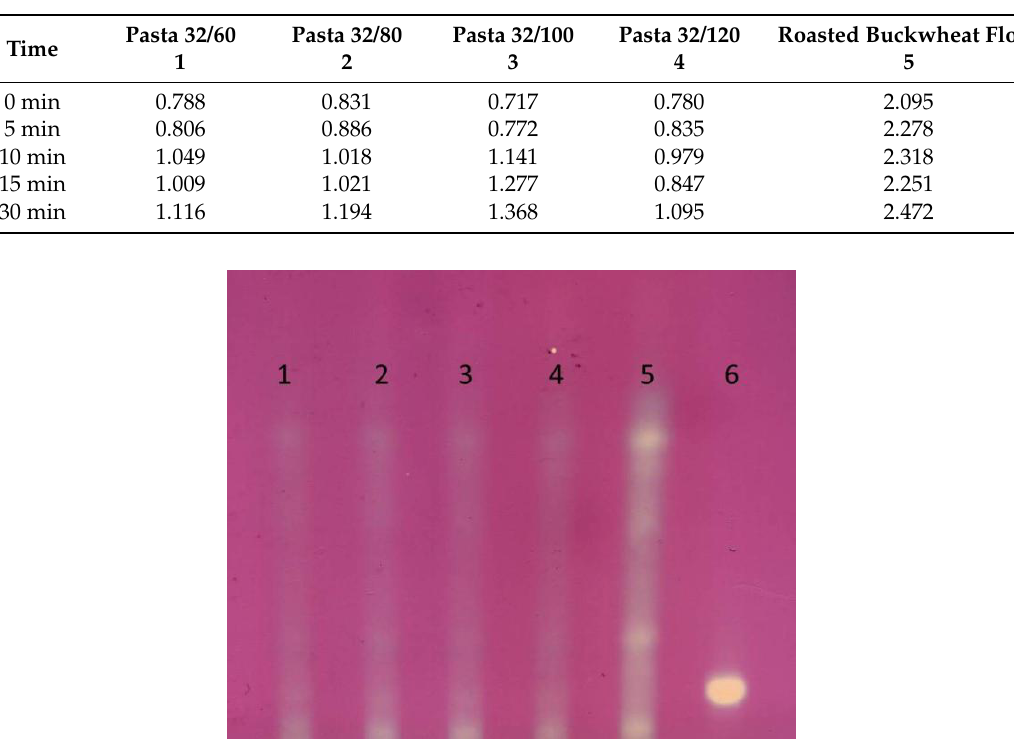
Table 3. Results of TLC-DPPH assay showing the antiradical activity of analyzed extracts in relation to the activity of 0.1 mg/mL rutin solution (activity of rutin solution equal to “1”).